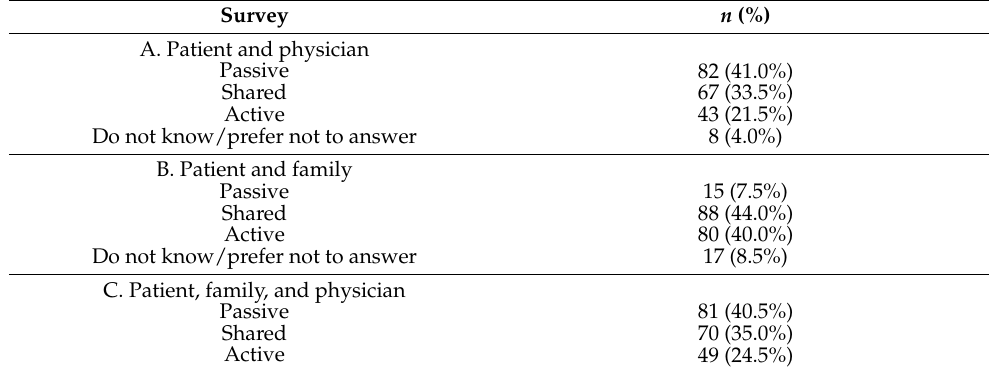
Table 2. Distribution of decision role preferences according to the independent relationships between patient and physician; patient and family; and the relationships among the patient, family, and physician ( n =